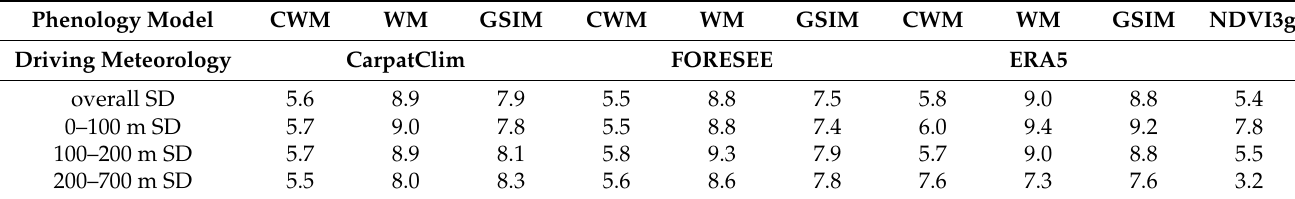
Table 3. Interannual variability (expressed as standard deviation in days, SD) of the annually calculated median SOS dates for the different model–database combinations and observations. Data are shown for the selected elevation classes and the whole study area.